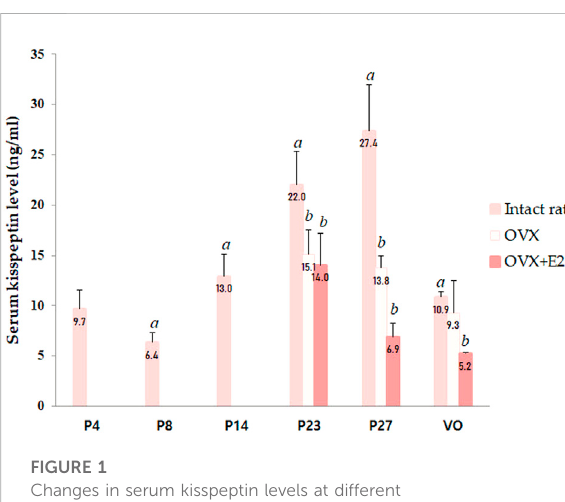
FIGURE 1 Changes in serum kisspeptin levels at different developmental stages. Serum kisspeptin levels in intact female rats; changes in serum kisspeptin levels in ovariectomized (OVX) and estradiol-treated OVX female rats (OVX + E2) were measured. Specimens were collected on days 4, 8, 14, 23, and 27, and on the day of vaginal opening (VO) in intact female rats. Ovariectomywasconductedonday14;specimenswerecollected on days 23, 27, and on the day of vaginal opening (VO) or day 34 in OVX and OVX-estradiol treated rats. Each group had four to eight animals. Dataarepresentedasthemean±standarderrorofmean. a Signi fi cant difference ( p < 0.05) in treatments just before each stage; b Signi fi cantdifference( p < 0.05)inlevelscomparedtothose in intact female